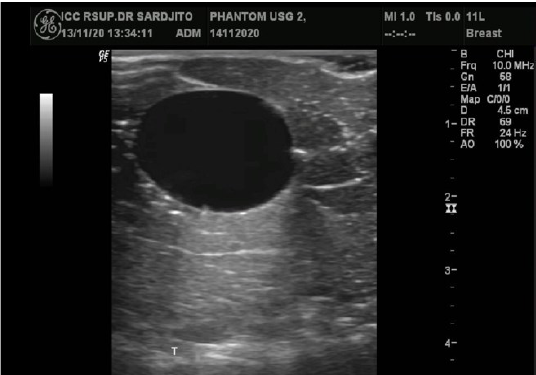
Fig.10: NOSER method with 16 (a) and 32 electrodes (b) of artificial cystic tumor shows a match between the reconstructed image and the original object containing one